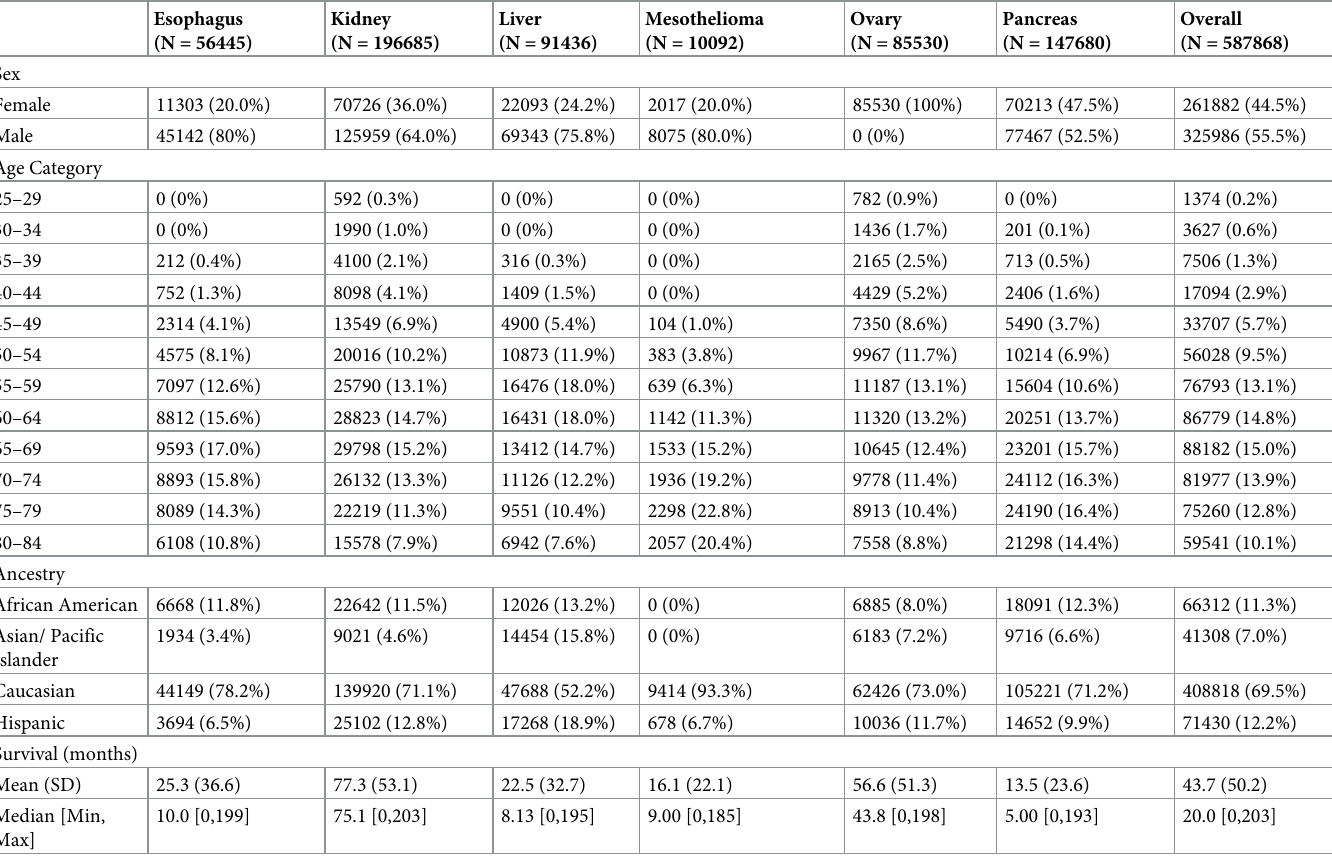
Table 1. A summary of the SEER cancer incidence data used in the modeling and comparison of putative screening